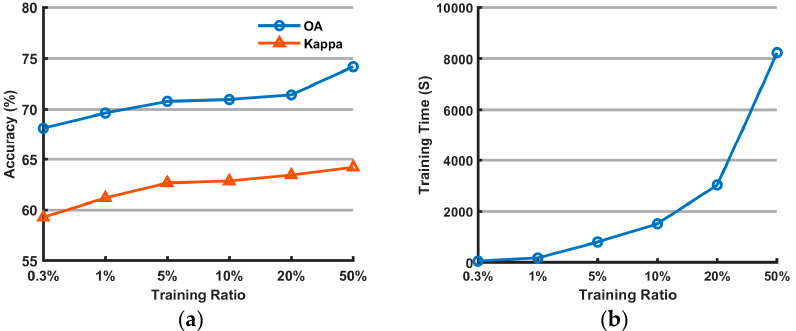
Figure 9. Classification accuracies and training time with different training ratios: ( a ) classification accuracy and ( b ) training time.